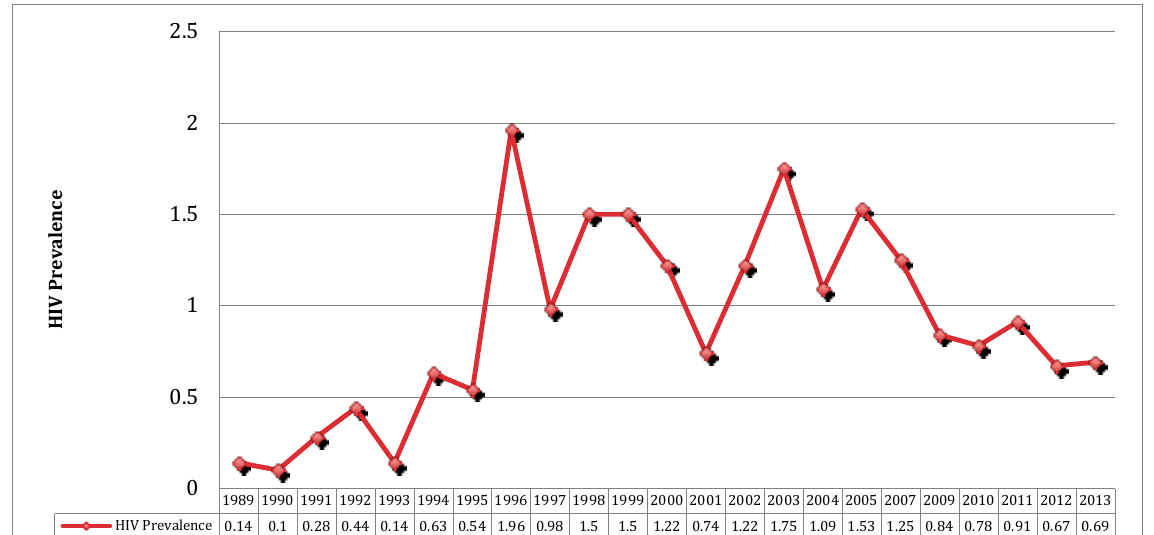
Figure 4: HIV prevalence among public antenatal clinic attendees (15-24) in Jamaica,